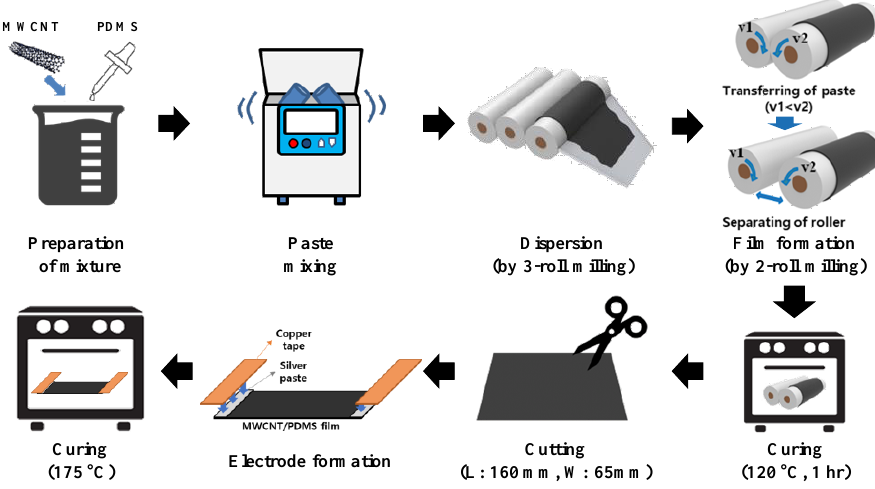
Figure 1. A schematic of fabricating MWCNT/PDMS composites.